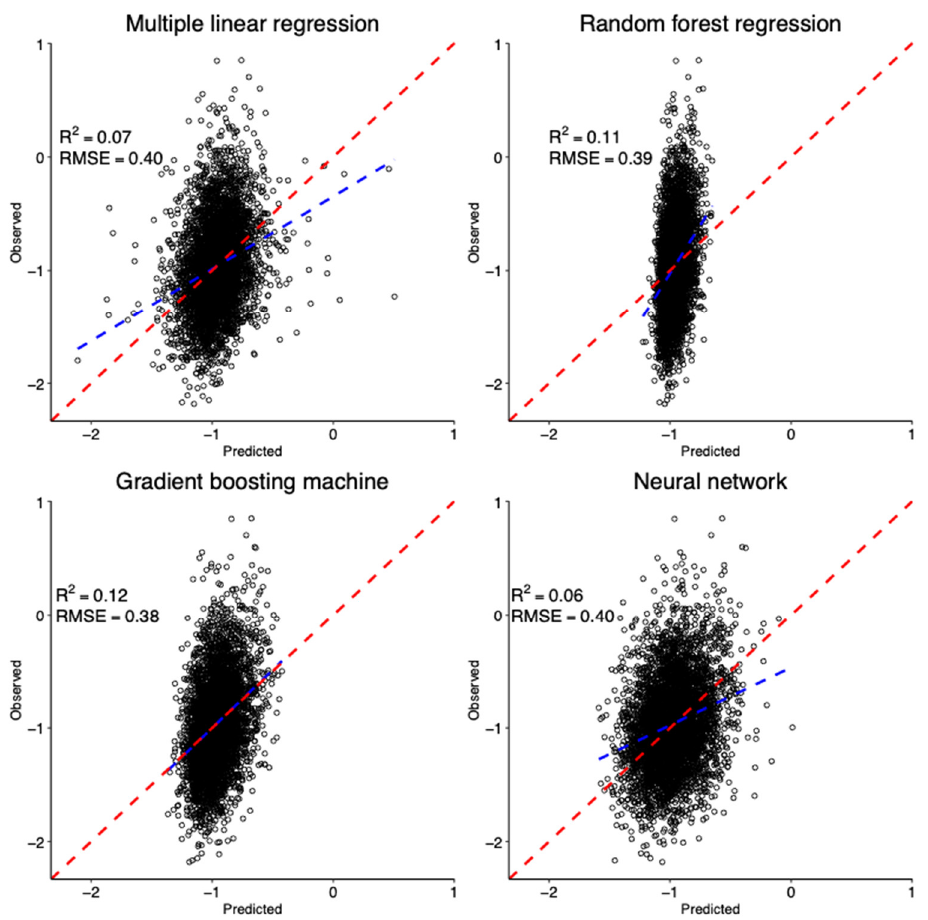
Figure 1. Ten-fold cross-validation of the multiple linear regression, random forest regression, gradient boosting machine and neural network models for urinary DAP concentrations. The blue dotted lines represent the regression lines of the ordinary least square model between predicted and observed concentrations. The red dotted lines have a slope of 1. R 2 , coefficient of determinant; RMSE, root mean square error.